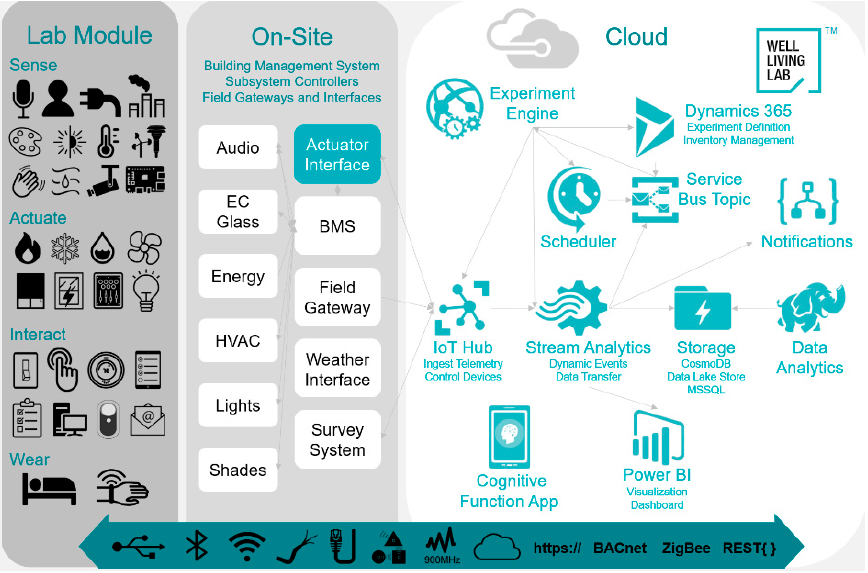
Figure 4. Schematic chart of the IoT system for environmental control and data collection.